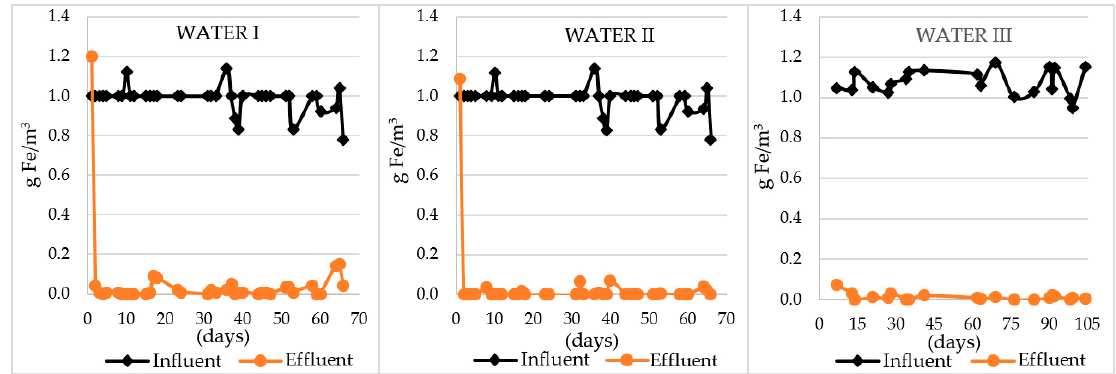
Figure 6. Change in the content of iron compounds after biofiltration on the chalcedonite bed in the analyzed systems.